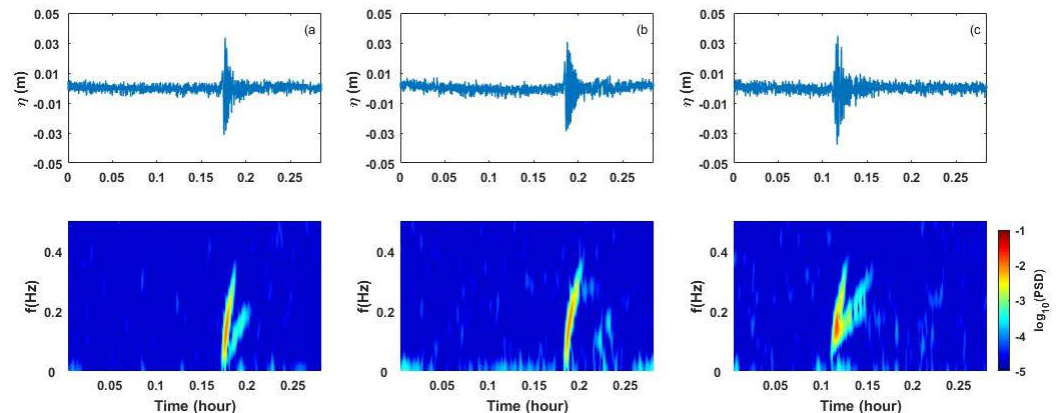
Figure 3. Selected wake events observed during the first deployment at CP. Top panels show the 17-min burst time series of water surface elevation. Bottom panels show the wakes Spectrograms. ( a ) Wake event in 22nd May at 10 am, ( b ) wake event in 2nd June at 4pm, and ( c ) wake event in 6th June at 12 am. η is the water level and f is the frequency.